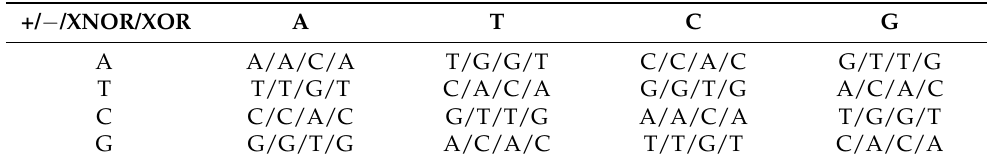
Table 2. DNA coding operations.